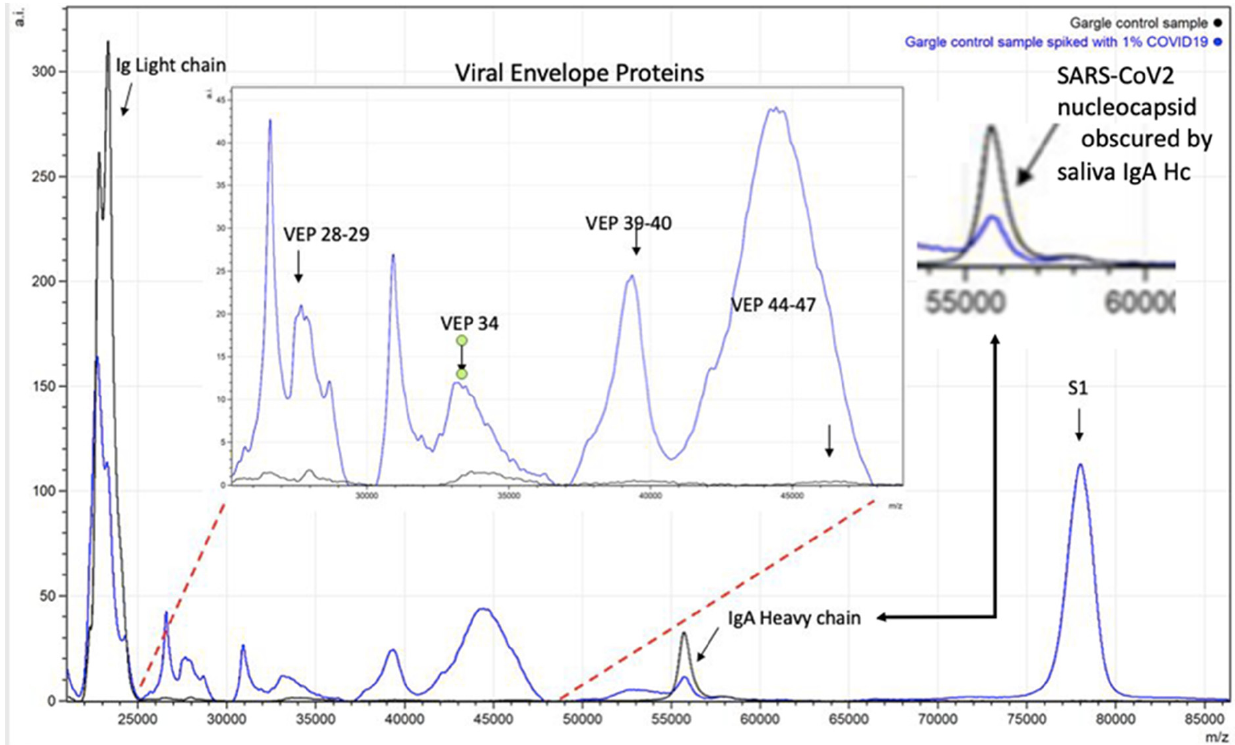
Figure 6. Spectra illustrating how endogenous sample proteins from gargle-saliva can hide key virion proteins (VEPs) such as nucleocapsid peaks by co-enrichment of endogenous IgA.